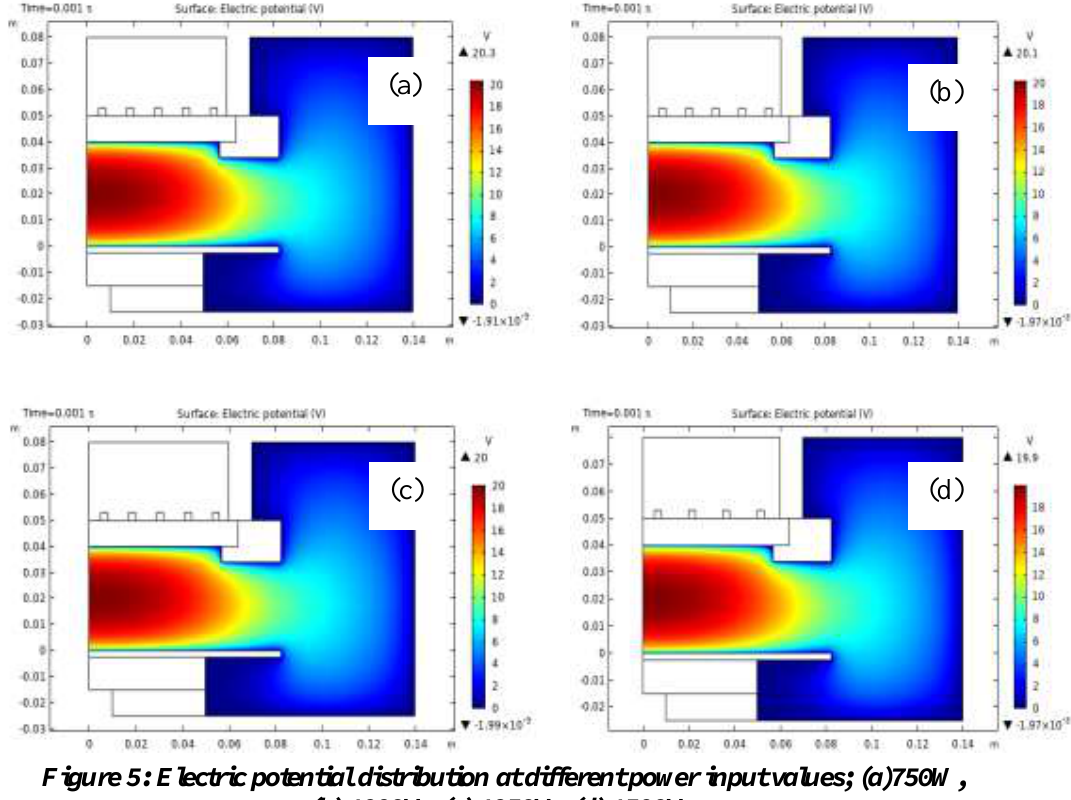
Figure 5: Electric potential distribution at different power input values; (a)750W, (b) 1000W, (c) 1250W, (d)